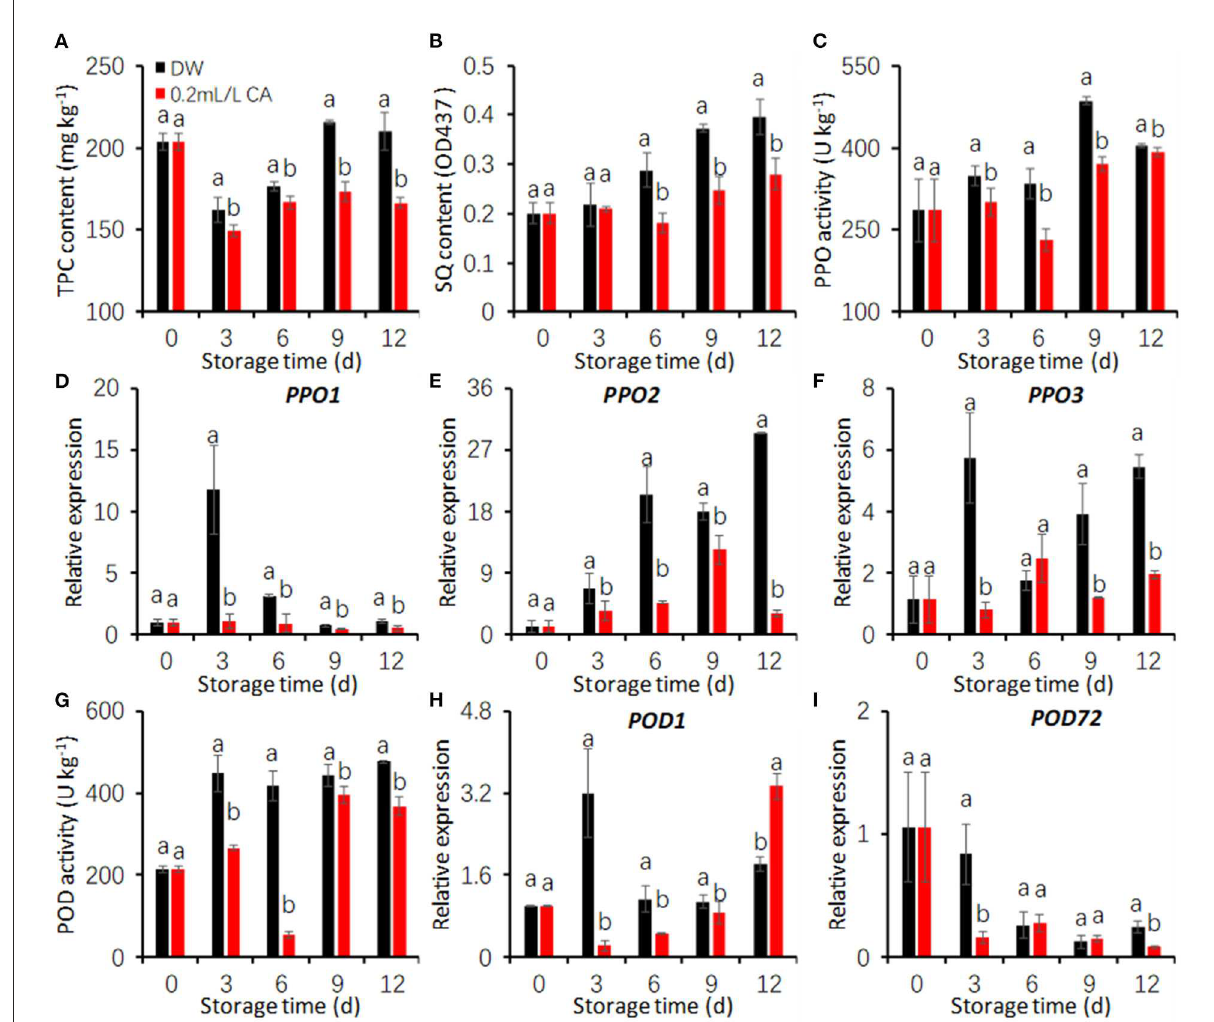
FIGURE3 Effects of 0.2 mL/L citronellal (CA) treatment on the oxidation of phenolics in fresh-cut taros. (A) Total phenolic compound (TPC) content; (B) soluble quinone (SQ) content; (C–F) PPO activity and gene expression; (G–I) POD activity and gene expression. DW, distilled water. The expression levels were all normalized to 100% (1.0) at 0 d (before treatment). Each value is presented as the mean ± SE ( n = 3). Statistical differences ( p ≤ 0.05) are indicated as different letters above the